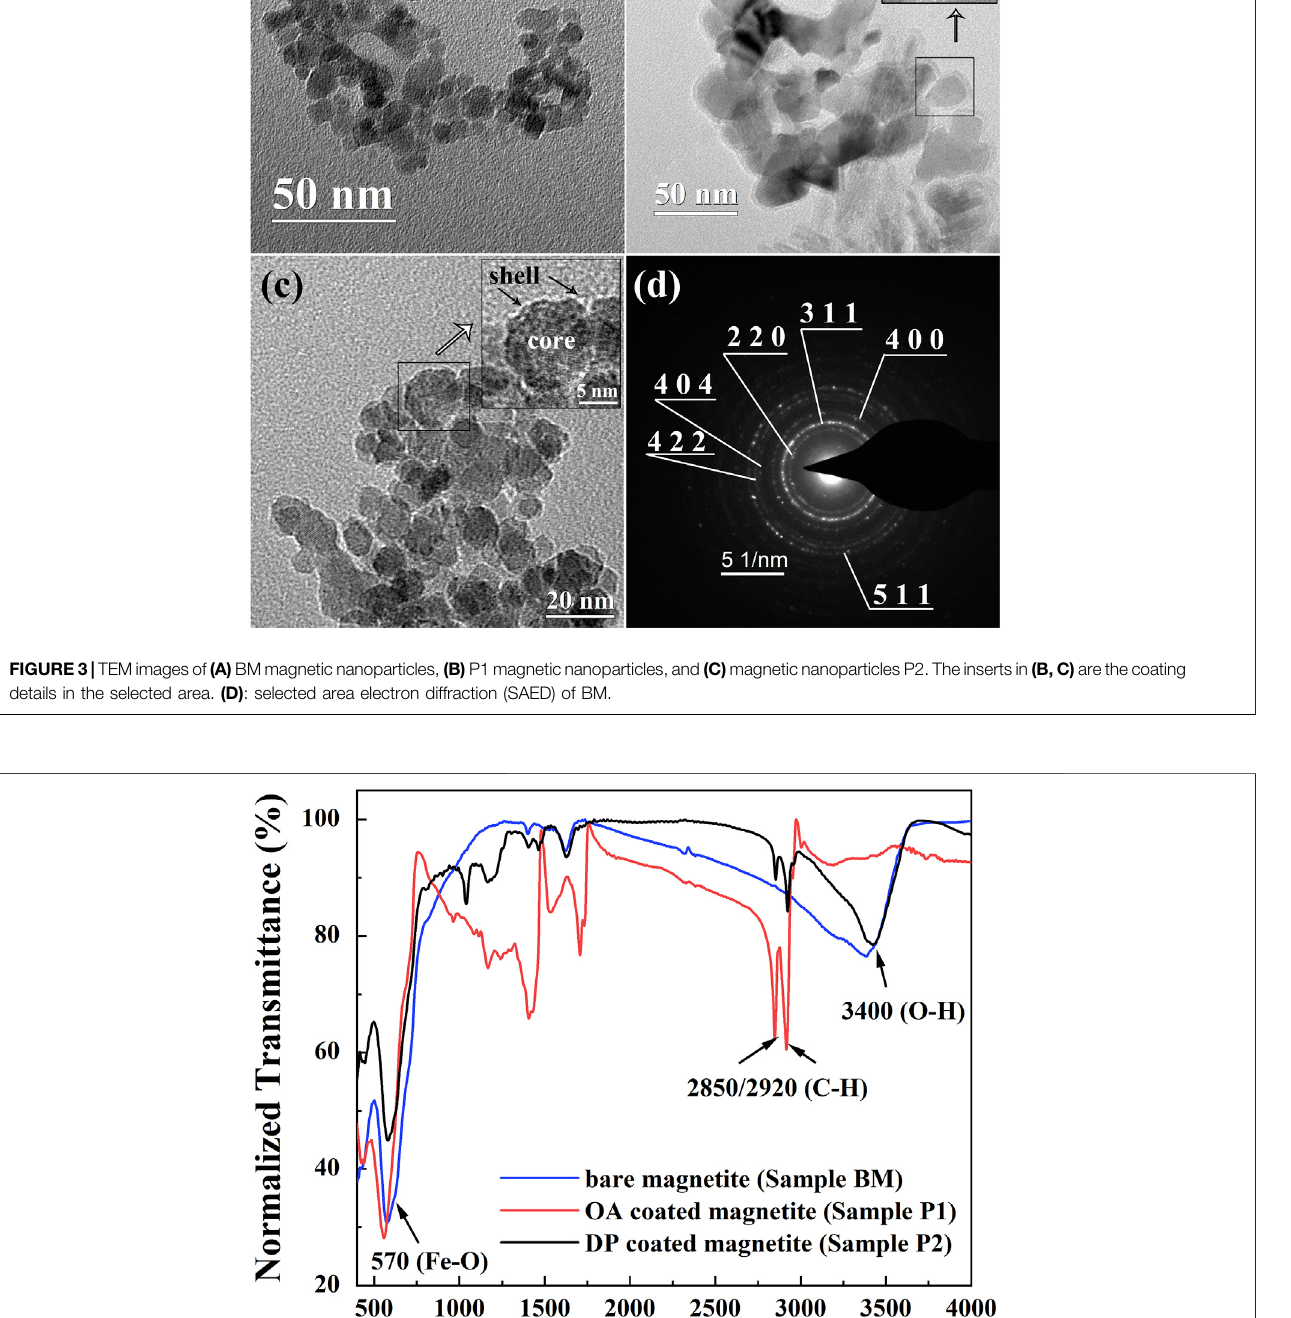
Frontiers in Materials |